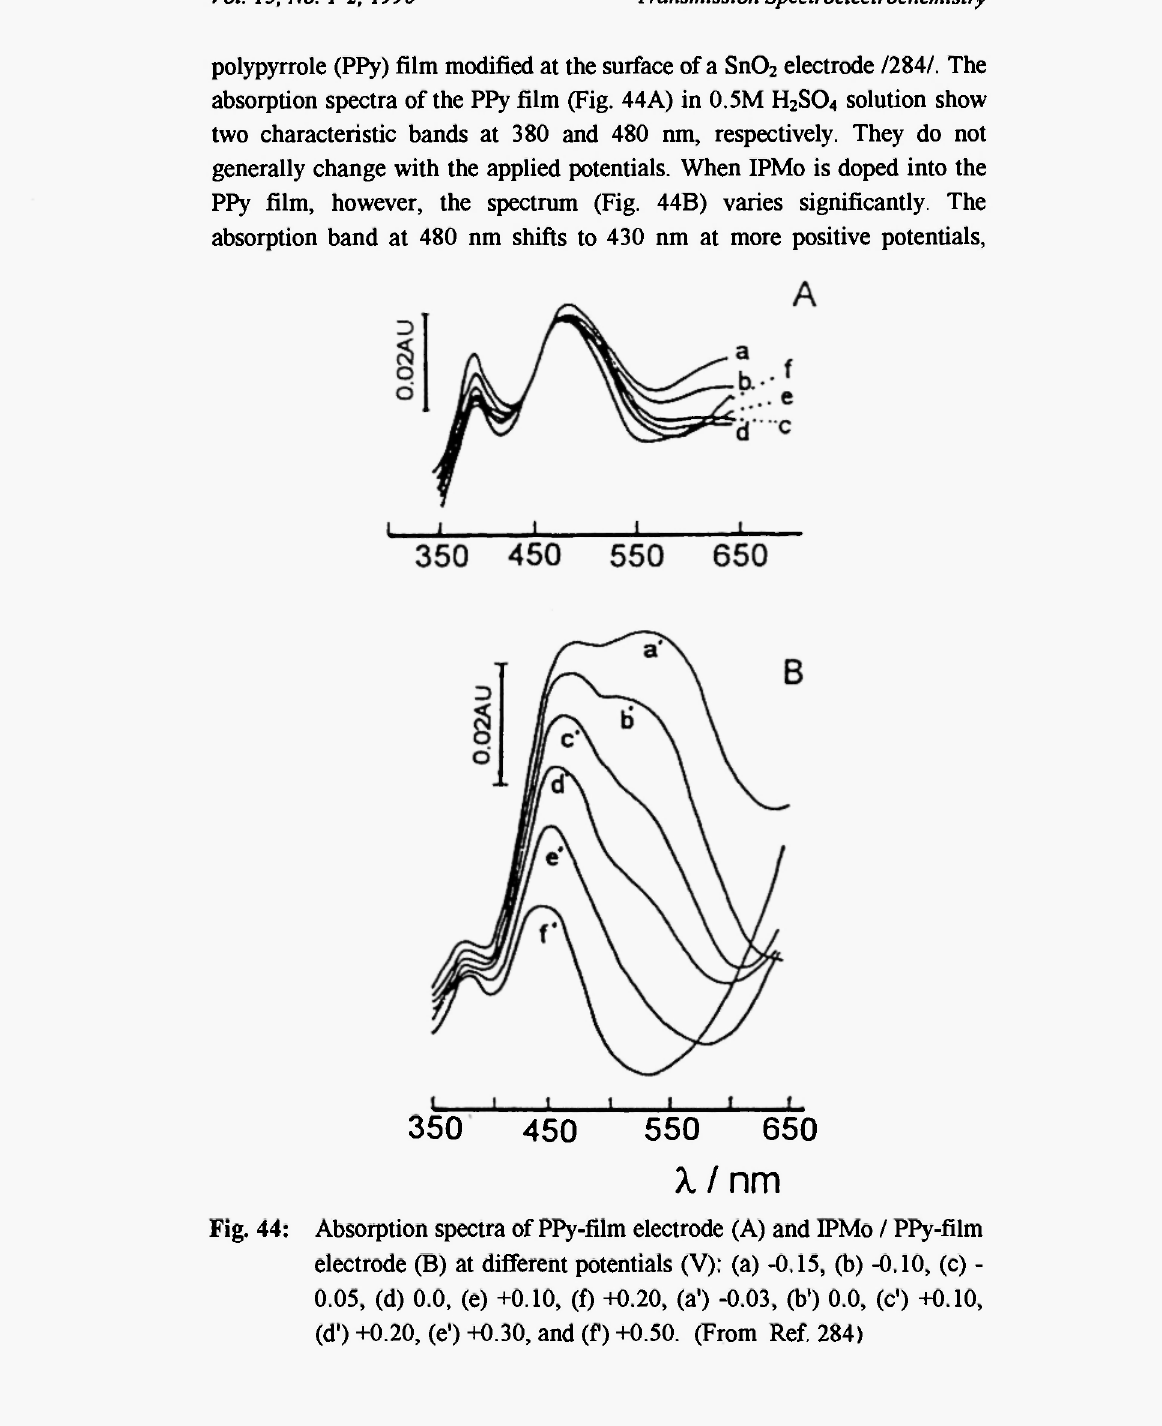
Fig. 44: Absorption spectra of PPy-film electrode (A) and IPMo / PPy-film electrode (B) at different potentials (V): (a) -0.15, (b) -0.10, (c) - 0.05, (d) 0.0, (e) +0.10, (f) +0.20, (a') -0.03, (b') 0.0, (c 1 ) +0.10, (d') +0.20, (e') +0.30, and (f) +0.50. (From Ref.